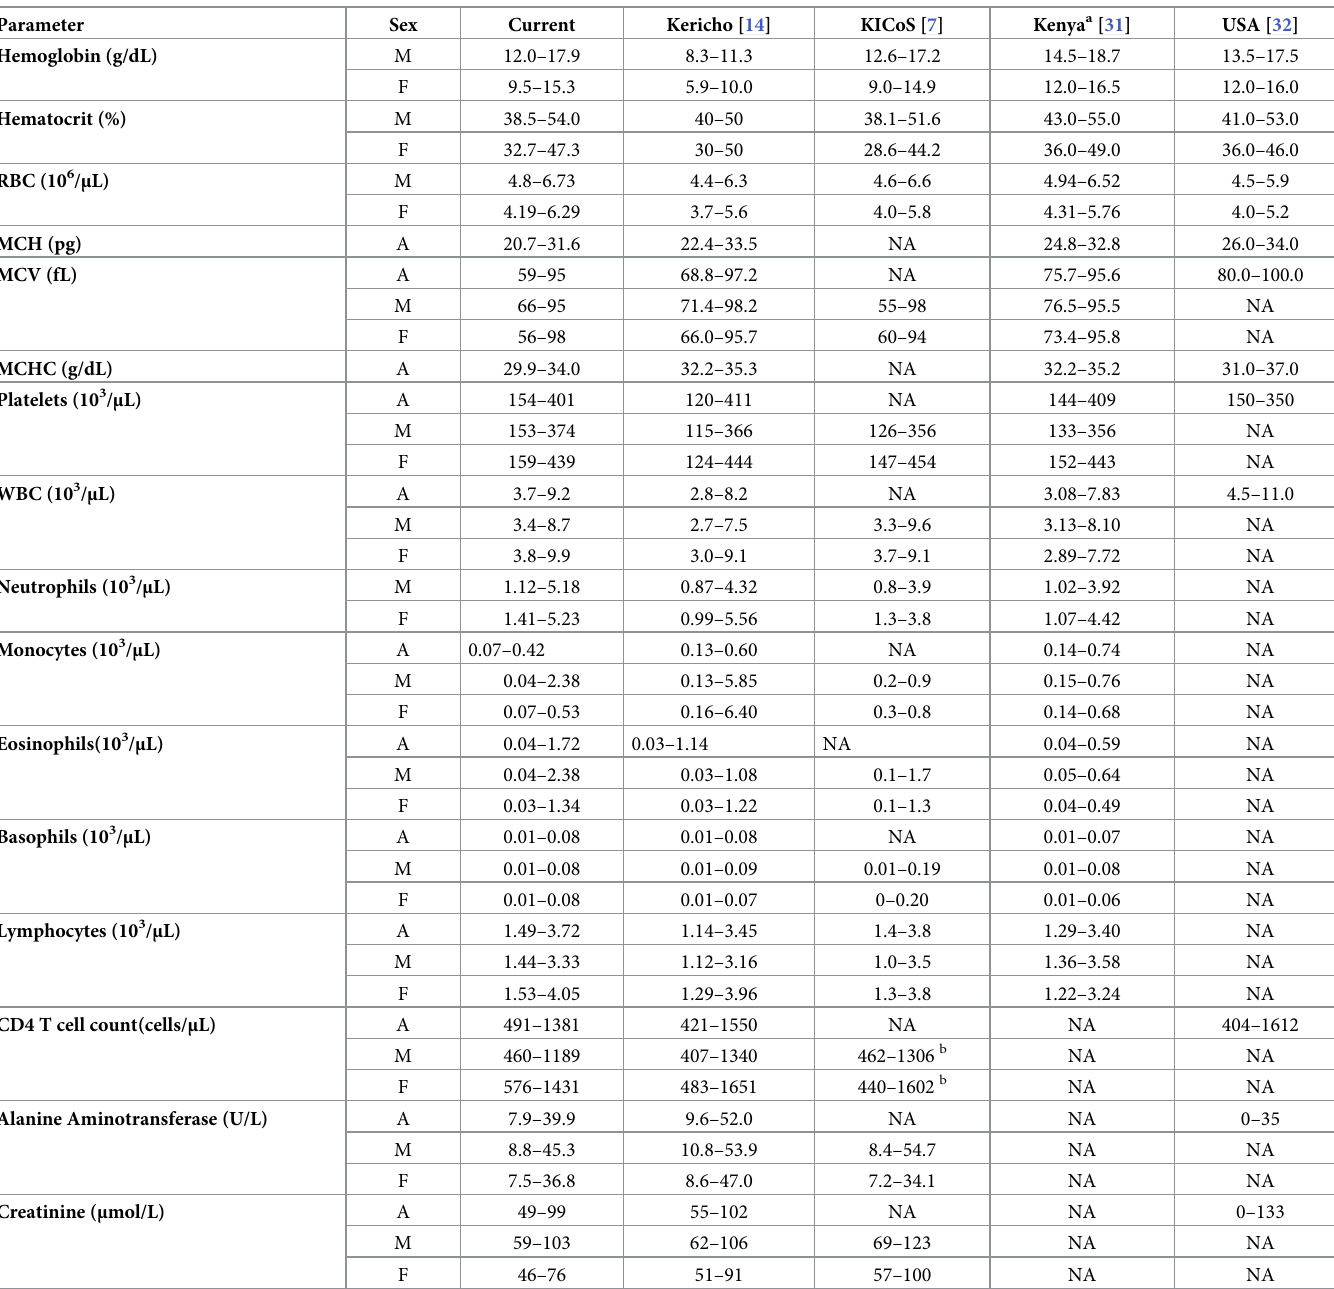
Table 3. Hematology, chemistry, and CD4 T cell count reference intervals (2.5 th to 97.5 th percentile) in Kisumu County (current study) compared to other